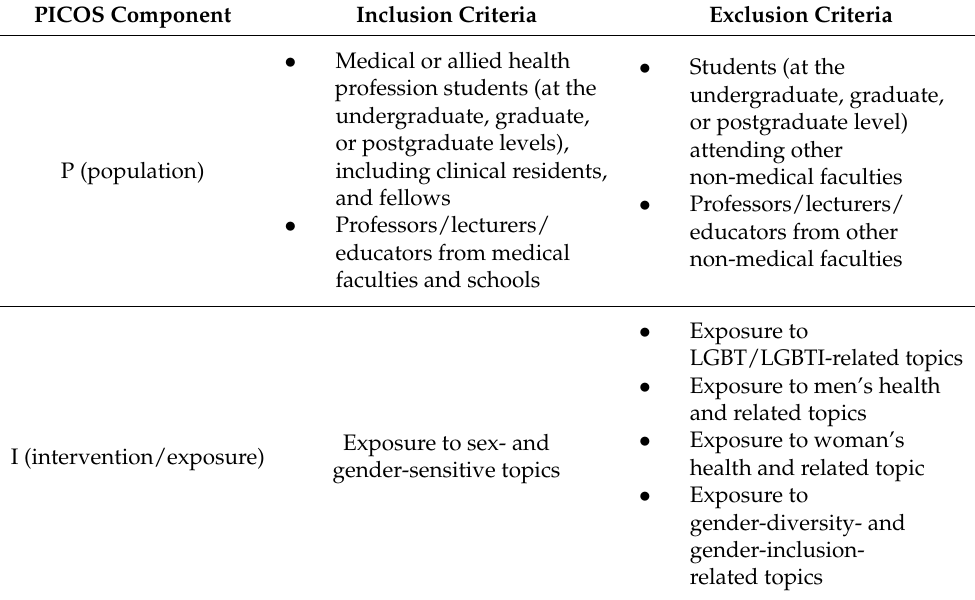
Table 1. Inclusion and exclusion criteria adopted in the present rapid systematic review of the